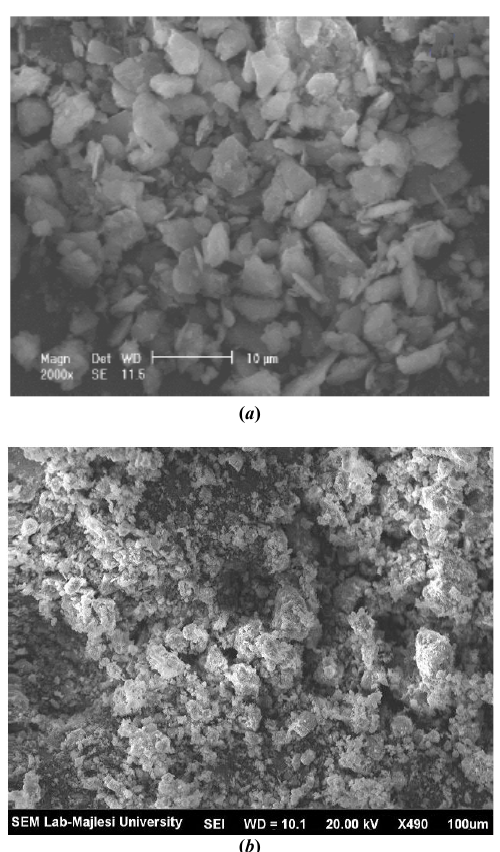
Fig. 3. (a) Scanning electron micrograph of natural clinoptilolite Fig. 3. (b) Scanning electron micrograph of clinoptilolite with immobilized yeast